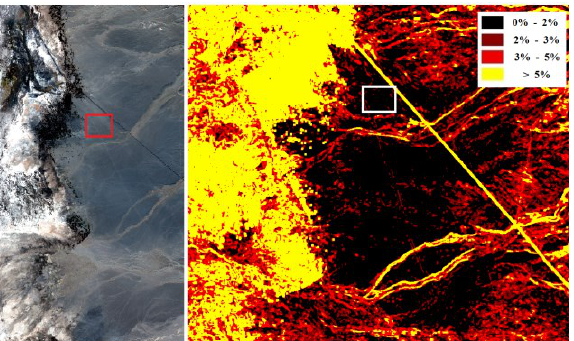
Figure 3. Spatial homogeneity of the calibration site in the Atacama Desert expressed in terms of spatial coefficient of